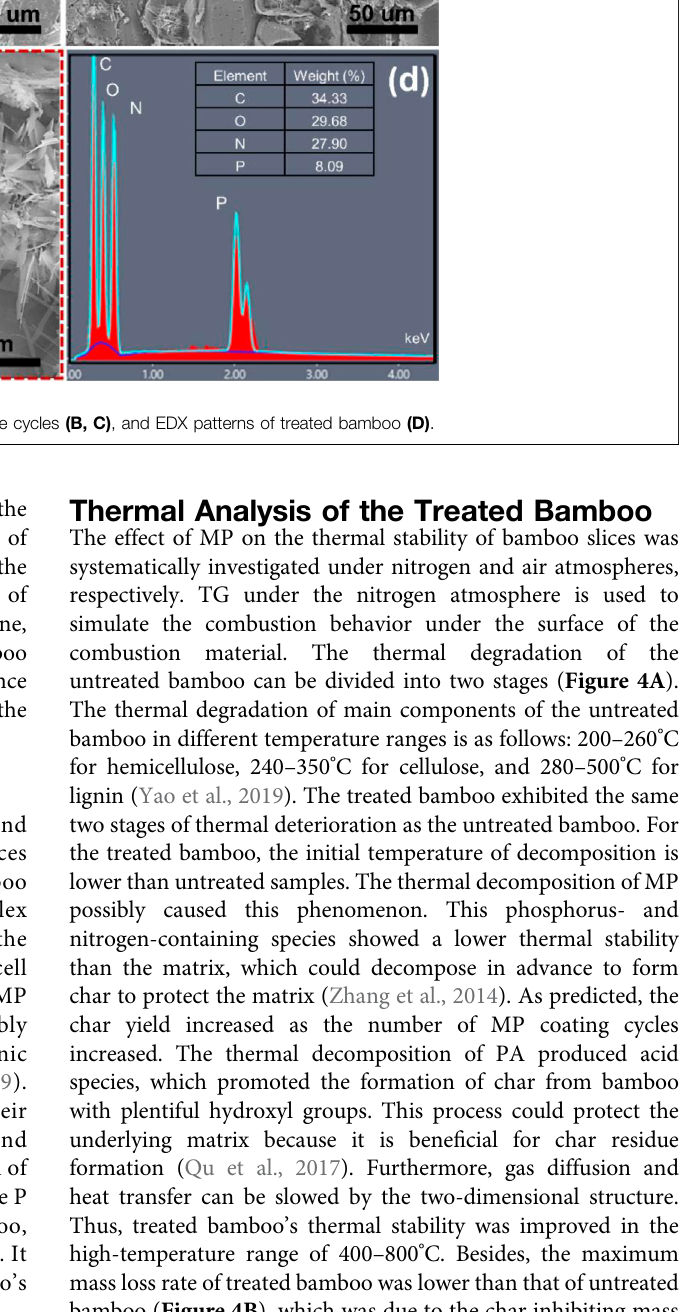
Frontiers in Materials |